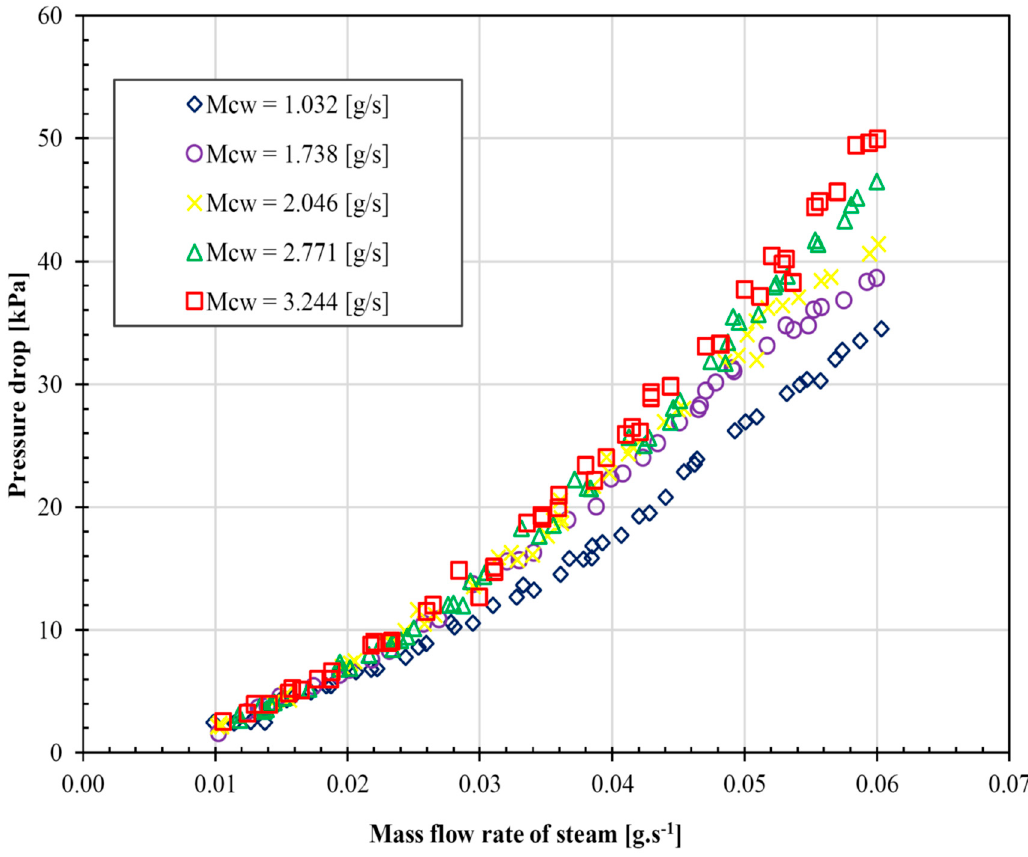
Figure 5. The effects of steam and cooling water mass flow rate on a horizontal microchannel. Figure 5. The e ff ects of steam and cooling water mass flow rate on a horizontal